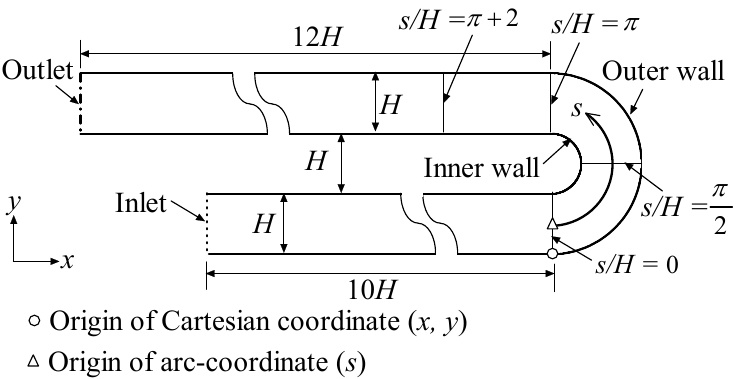
Figure 5. Computational model of the 2D U-turn duct flow.